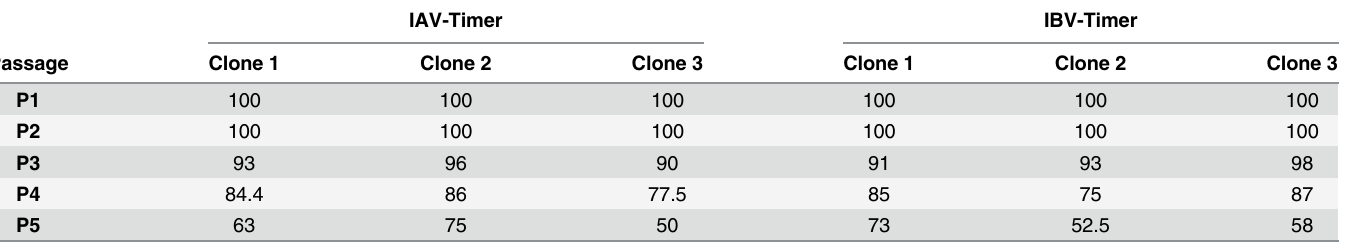
Table 1. Genetic stability of IAV- and